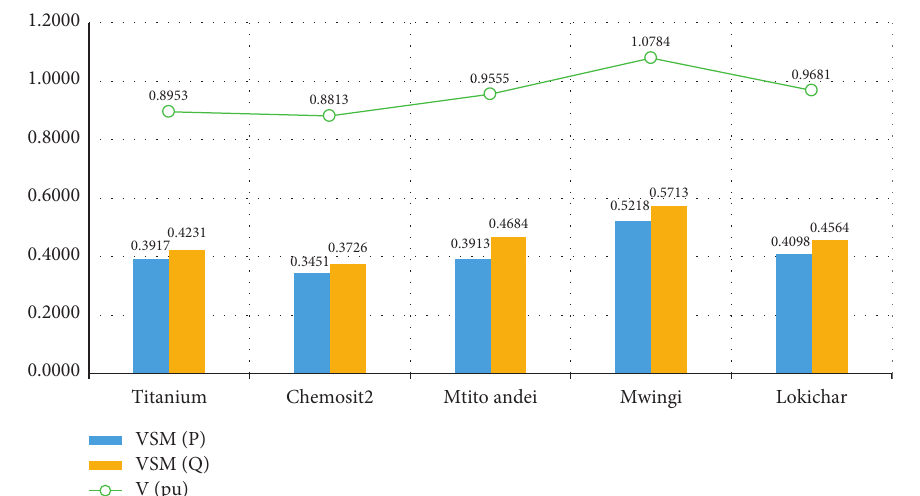
Figure 8: Comparison of bus voltages and voltage stability